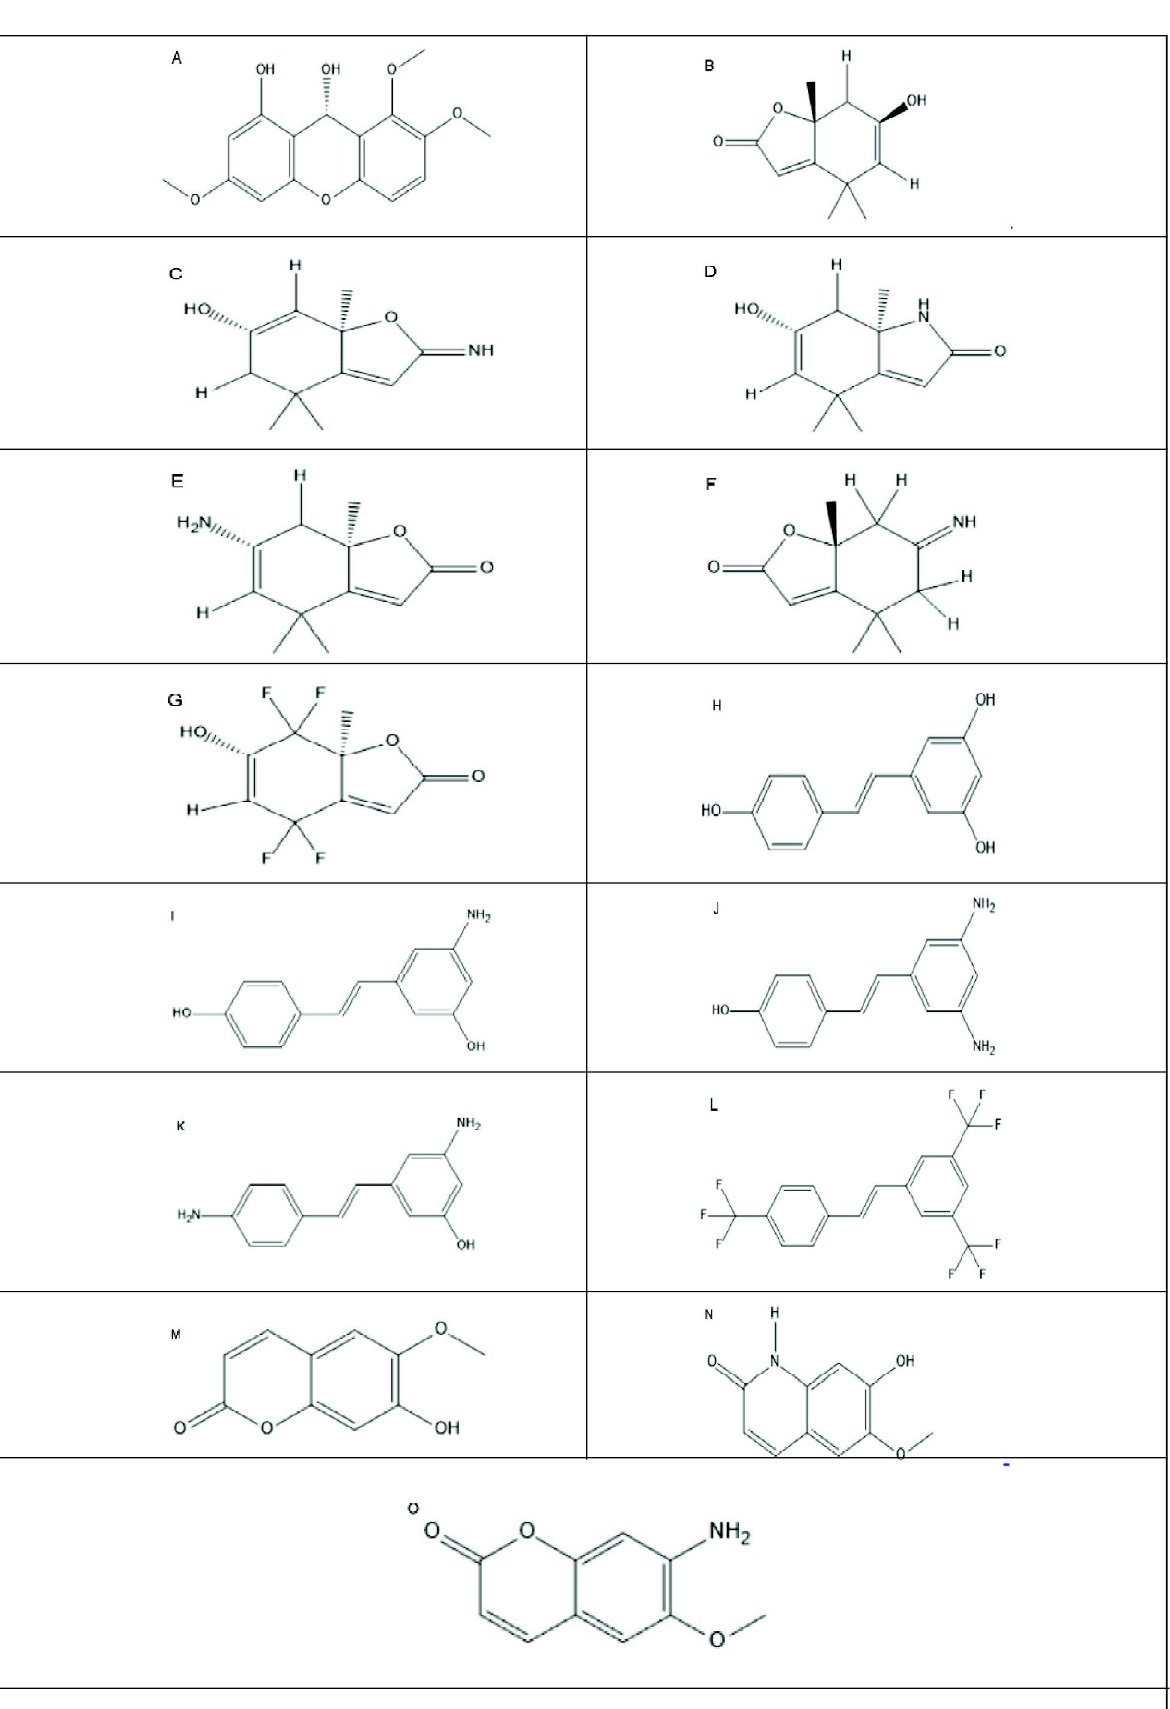
Figure 1: 2D structures of the ligand library: (A) Decussatin, (B-G): Loliolide (L, L1-6), (H-L): Resveratrol (R, R1-4), (M-O): Scopoletin (S,